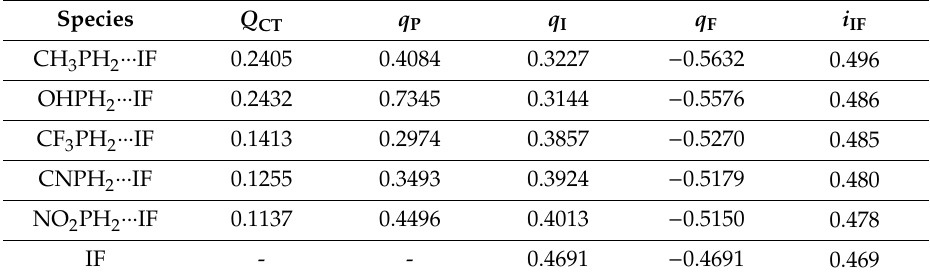
Table 7. Total RPH 2 → IF charge transfer ( Q CT ; e ), atomic charges ( q P , q I , q F ), and σ IF bond ionicity ( i IF ) in RPH 2 ··· IF complexes, compared with isolated IF